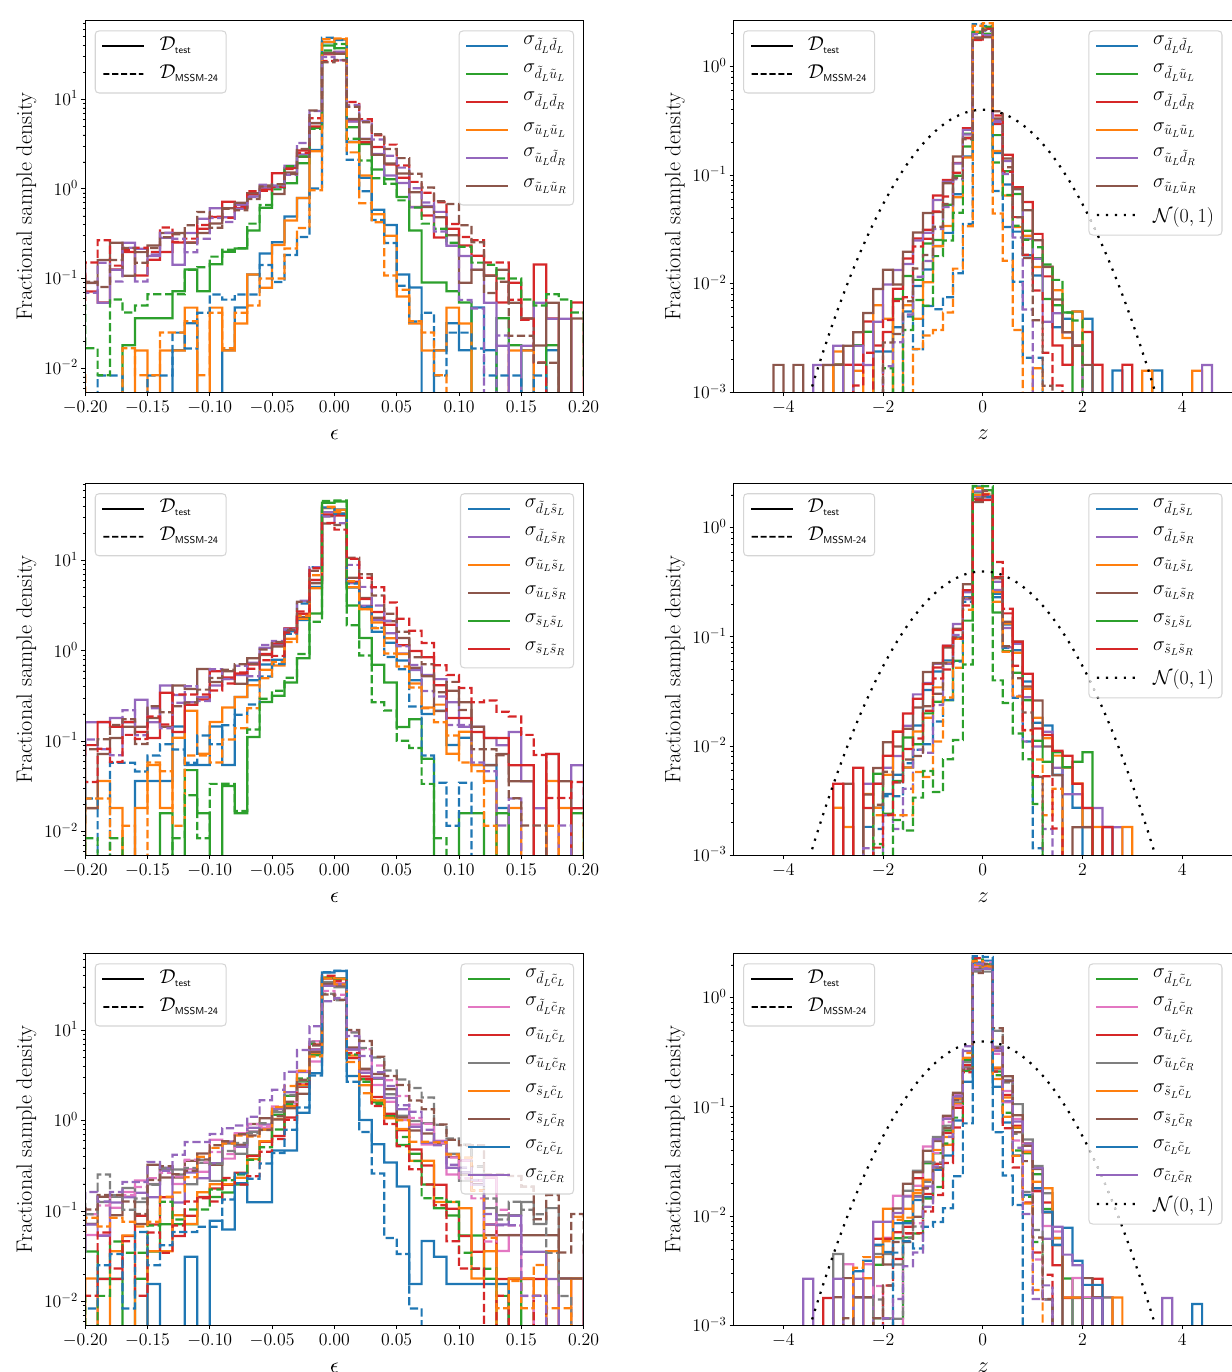
Fig. 16 The relative error (left) and residual (right) distributions for first and second-generation squark–squark pair-production cross-sections for the test sets D test (solid) and D MSSM-24 (dashed)